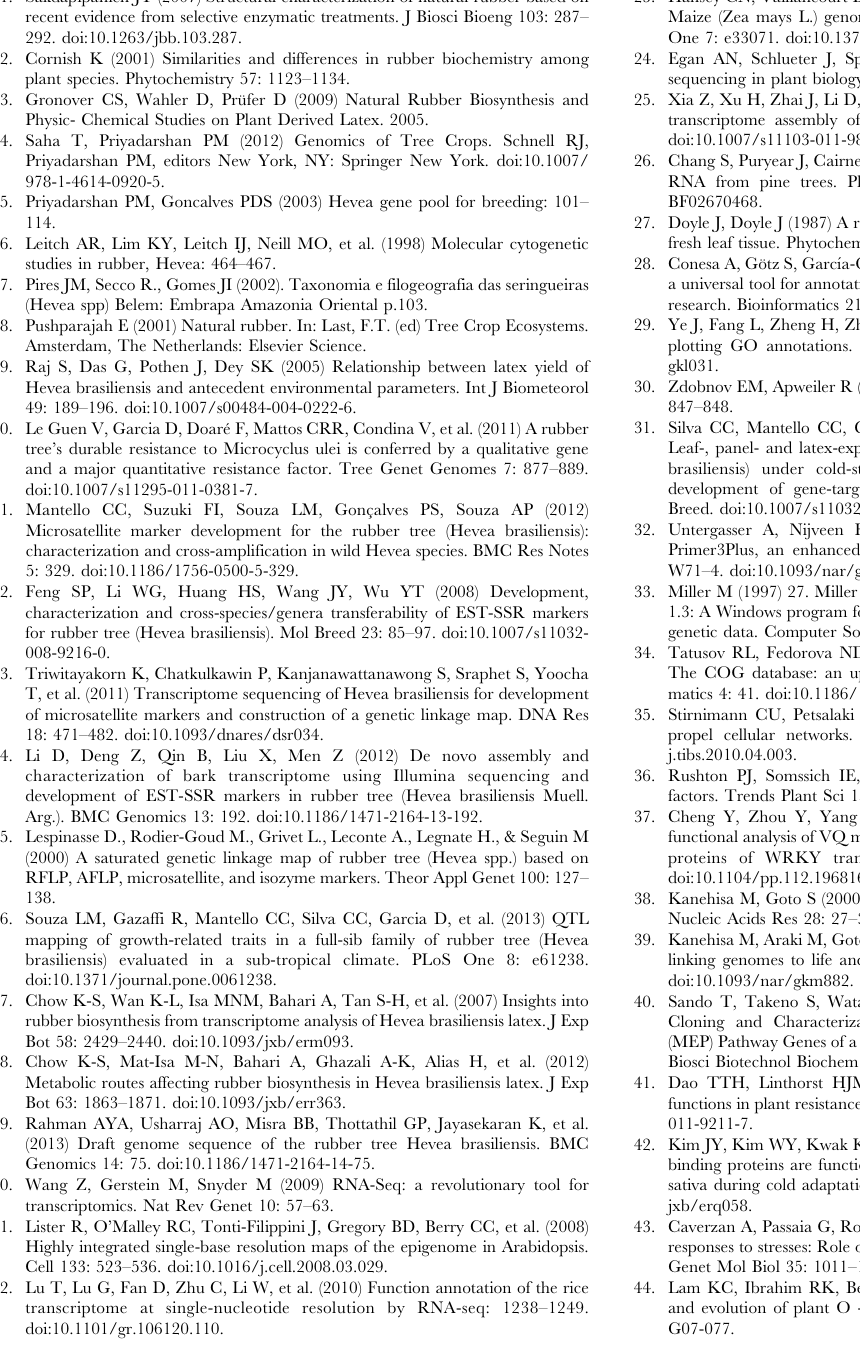
Table S7 Validation of the SNP markers. The table presents the allelic variants, observed and expected heterozygos- ities and polymorphism information